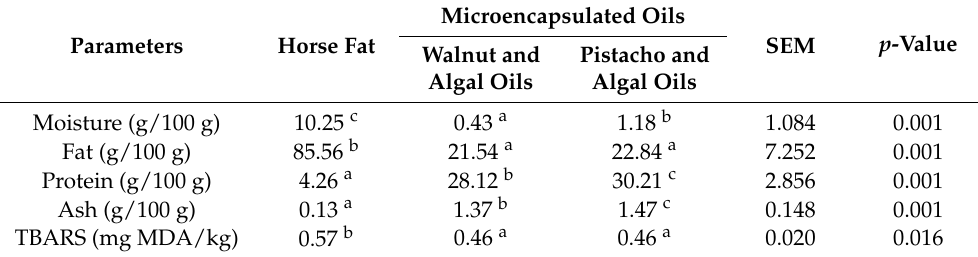
Microencapsulated Oils SEM p -Value Walnut and Pistacho and Algal Oils Algal Oils